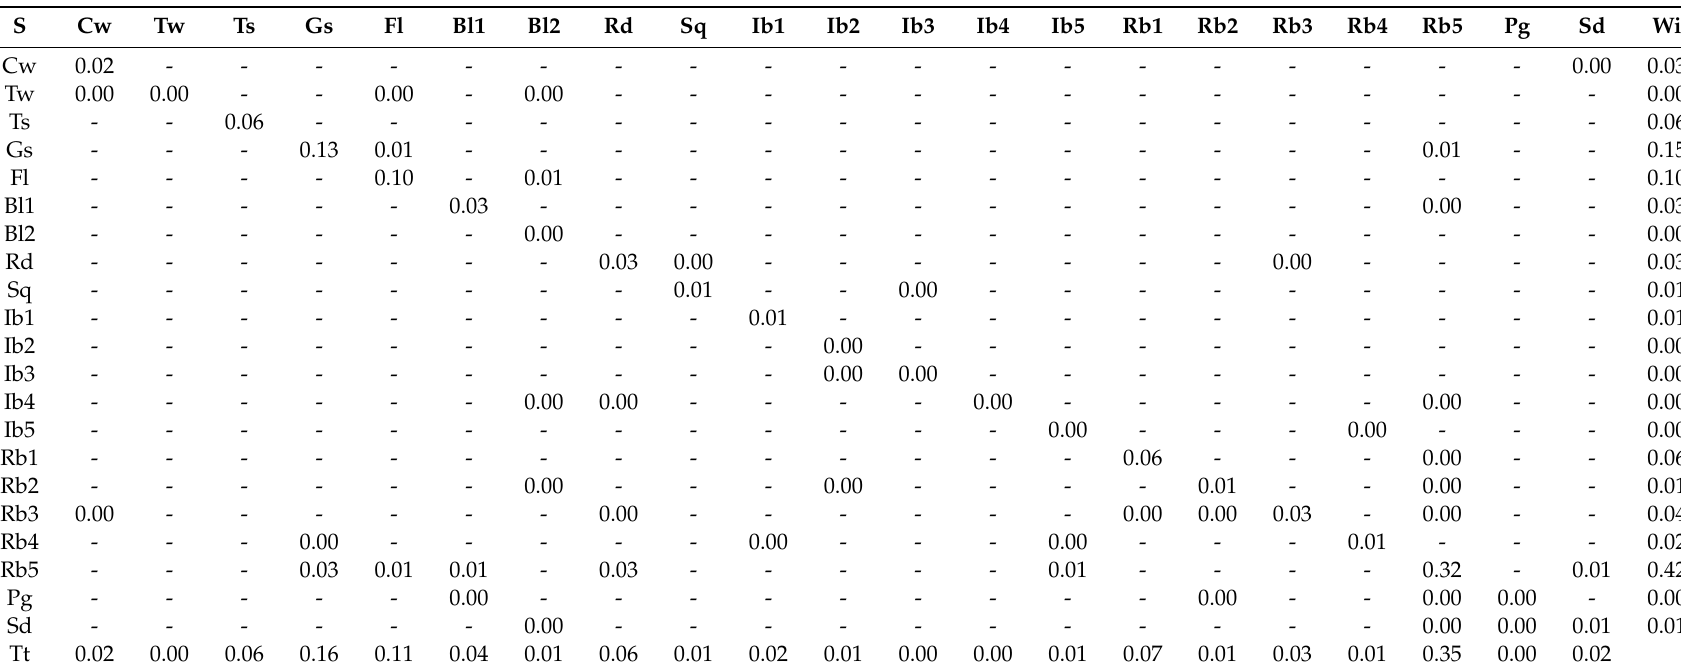
Table A2. Error matrix populated by estimated proportion of area for ULULC layer